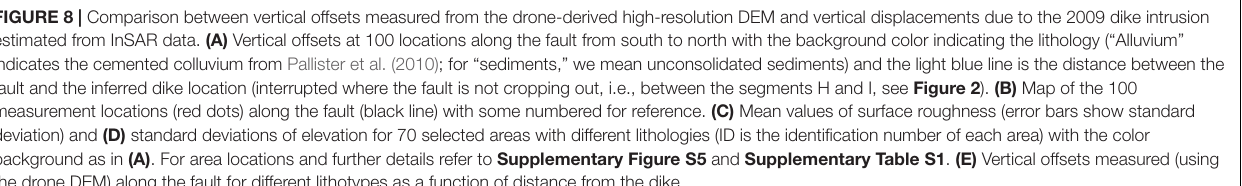
FIGURE 8 | Comparison between vertical offsets measured from the drone-derived high-resolution DEM and vertical displacements due to the 2009 dike intrusion estimated from InSAR data. (A) Vertical offsets at 100 locations along the fault from south to north with the background color indicating the lithology (“Alluvium” indicates the cemented colluvium from Pallister et al. (2010); for “sediments,” we mean unconsolidated sediments) and the light blue line is the distance between the fault and the inferred dike location (interrupted where the fault is not cropping out, i.e., between the segments H and I, see Figure 2 ). (B) Map of the 100 measurement locations (red dots) along the fault (black line) with some numbered for reference. (C) Mean values of surface roughness (error bars show standard deviation) and (D) standard deviations of elevation for 70 selected areas with different lithologies (ID is the identification number of each area) with the color background as in (A) . For area locations and further details refer to Supplementary Figure S5 and Supplementary Table S1 . (E) Vertical offsets measured (using the drone DEM) along the fault for different lithotypes as a function of distance from the